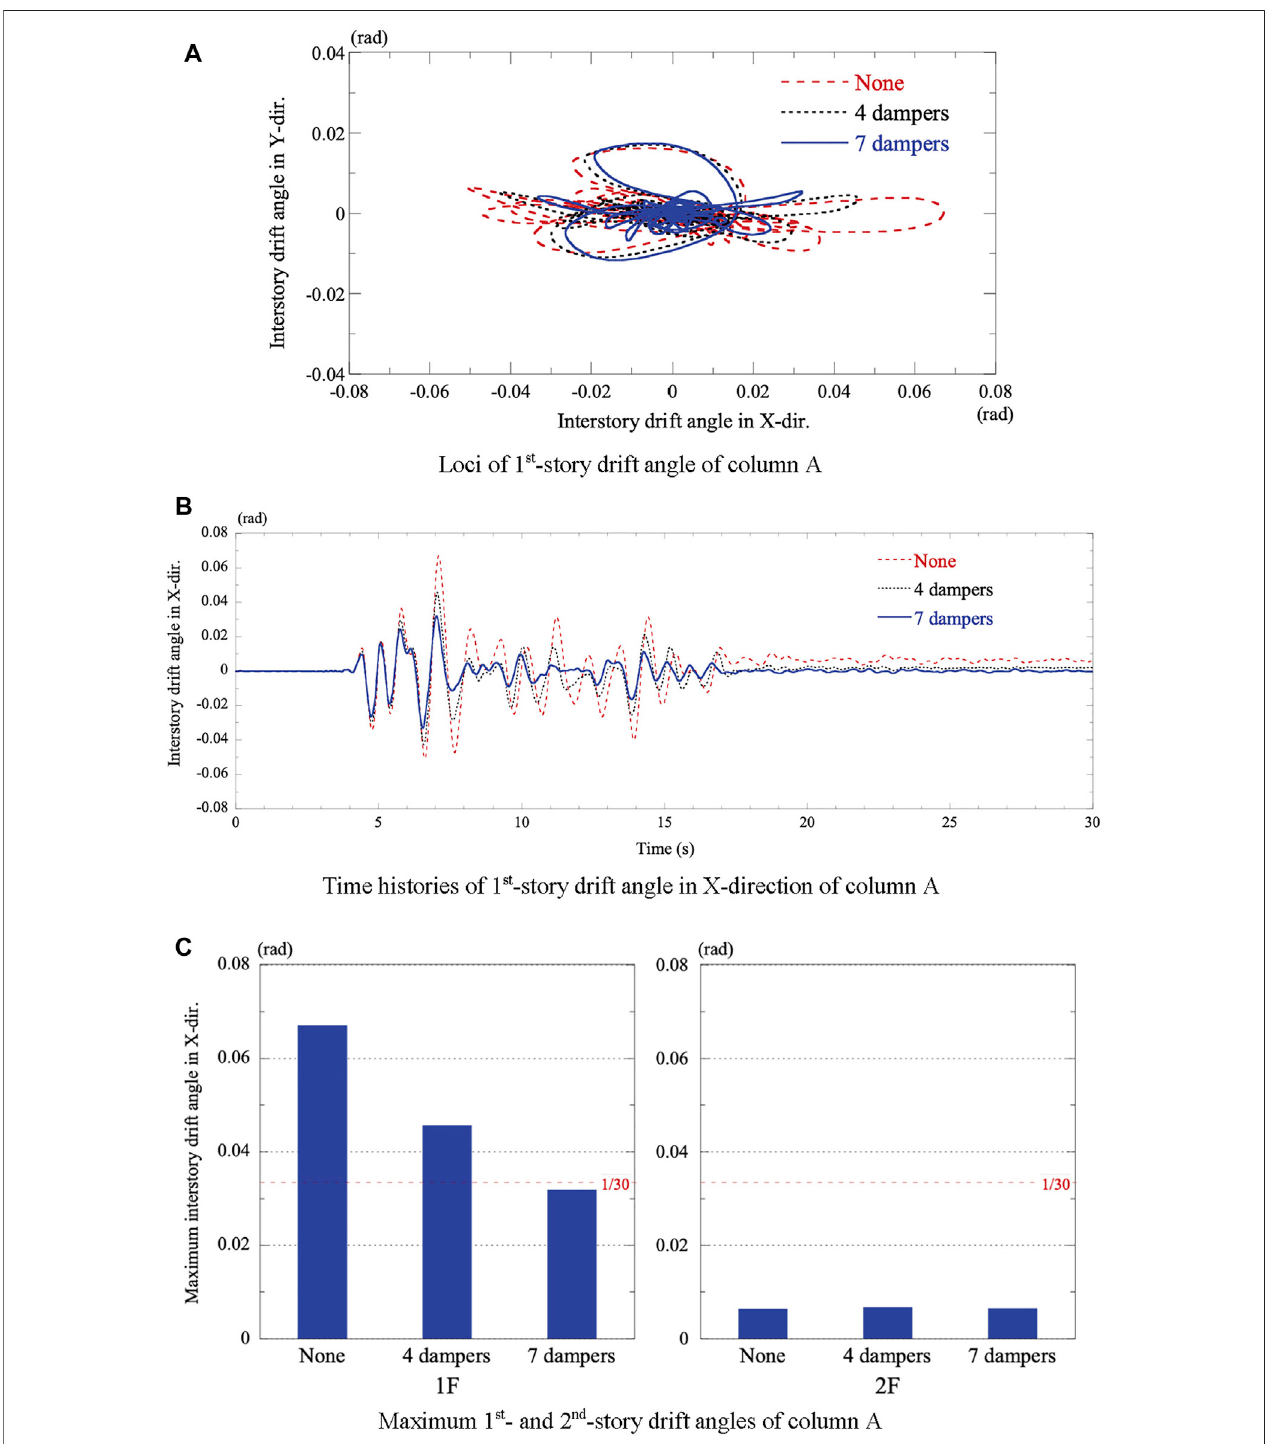
FIGURE11| Resultsofearthquakeresponseanalysesofthetimberhousewithandwithoutdampers. (A) Lociof1 st -storydriftangleofcolumnA. (B) Timehistories of 1 st -story drift angle in X-direction of column A. (C) Maximum 1 st - and 2 nd -story drift angles of column A.